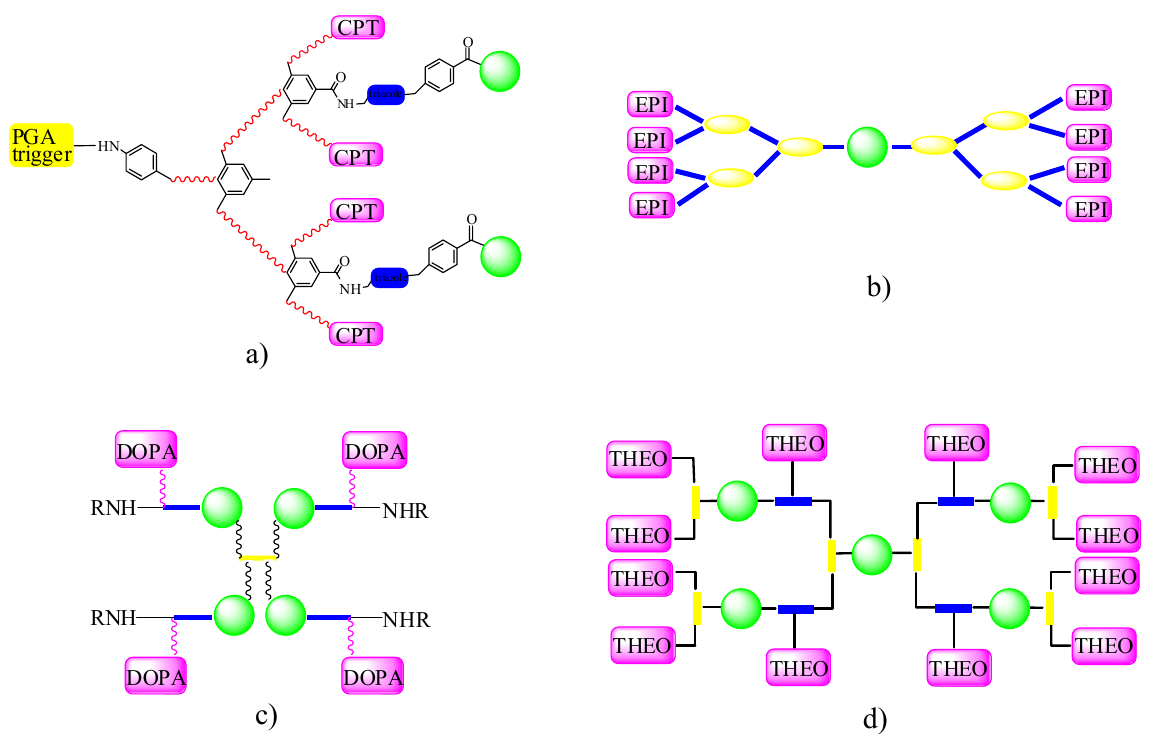
Figure 3. Examples of the structure of some PEG-supported multiconjugated derivatives: ( a ) PEG-Camptothecin (CPT); ( b ) PEG-Epirubicine (EPI); ( c ) PEG-DOPA; ( d ) MultiPEG-Theophylline